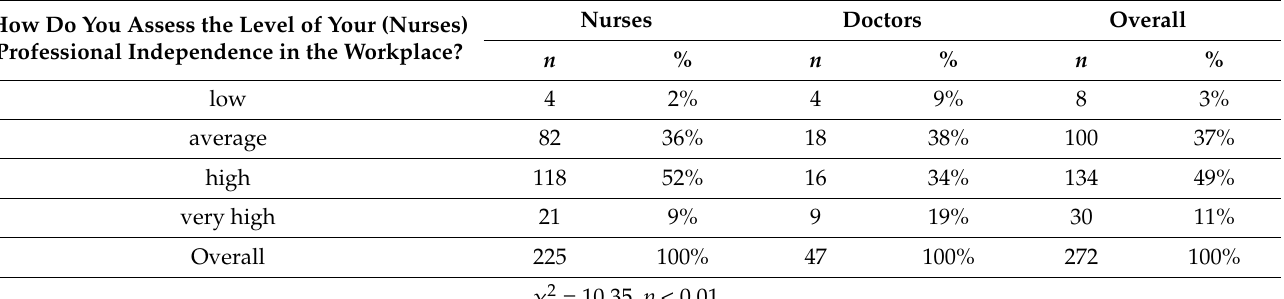
Table 2. Characteristics of the assessment of professional independence of nurses in the workplace in the group of